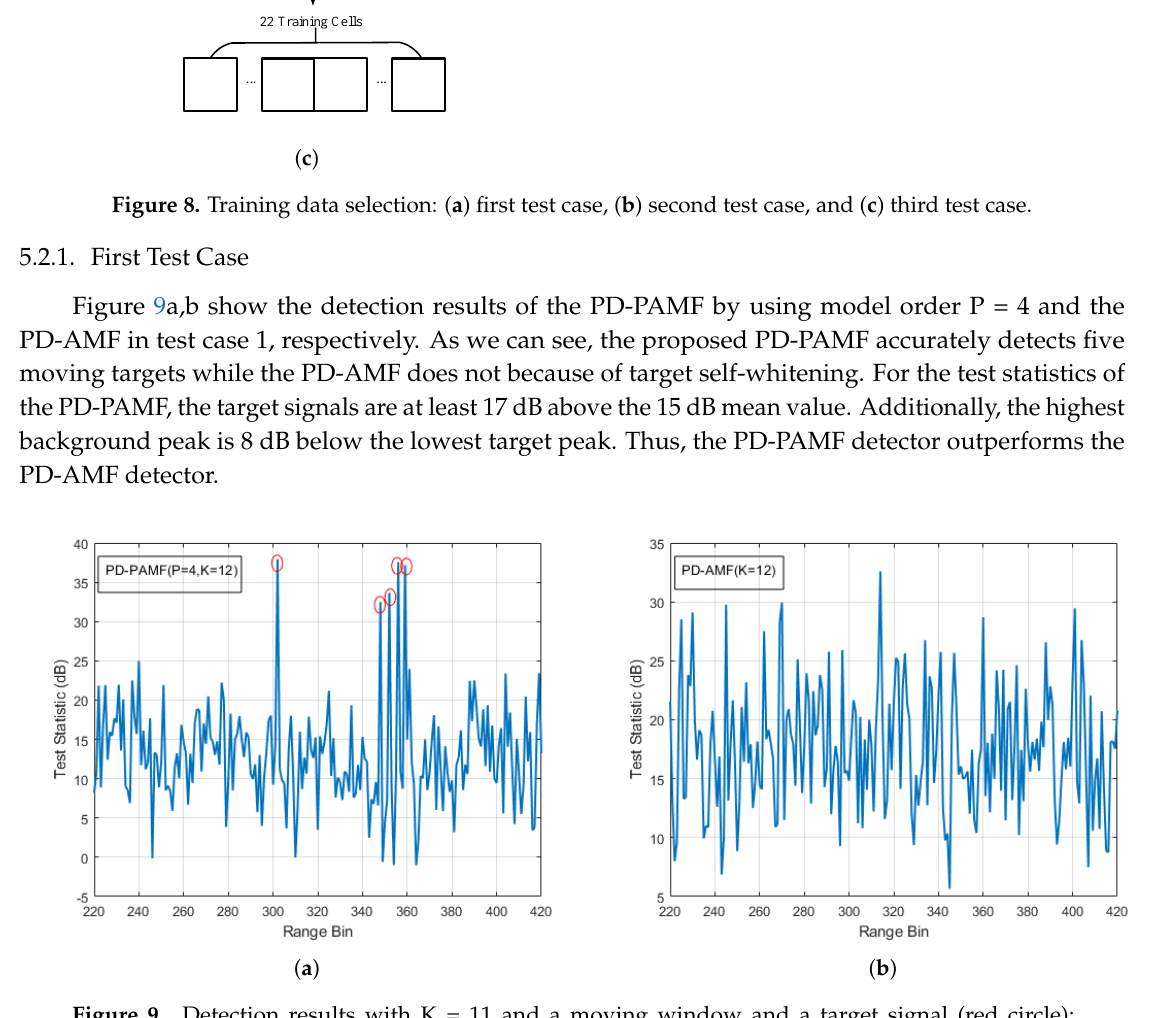
Figure 9. Detection results with K = 11 and a moving window and a target signal (red circle): ( a ) PD-PAMF test statistics, AR(4), five targets in R = 302, 348, 352, 356, and 359 and ( b ) PD-AMF test statistics, no